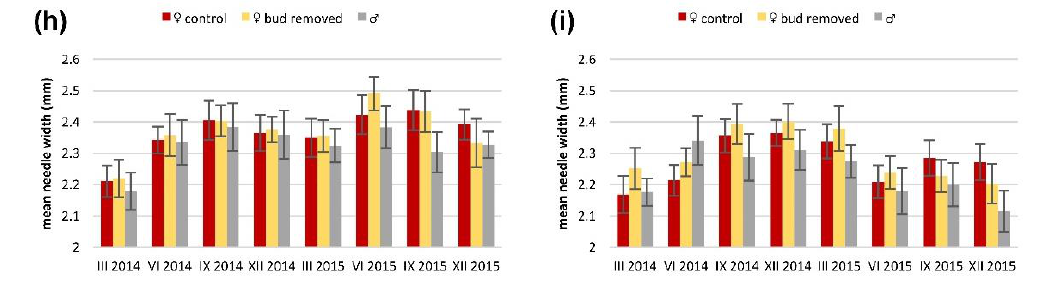
Figure 2. Mean values ( ± standard error) of ( a ) percentage of current-year increment in total dry mass of two-year increments; ( b , c ) specific leaf area; ( d , e ) mean needle area; ( f , g ) mean needle length and ( h , i ) mean needle width in ( b , d , f , h ) current-year increments; and ( c , e , g , i ) 1-year-old increments in control and bud-removed Taxus baccata shoots of females and males in different seasons for two years. The specific leaf area (SLA) values depended on the sex of the plants. Both groups of female shoots were different from male shoots in current and 1-year-old shoots (Supplemen-